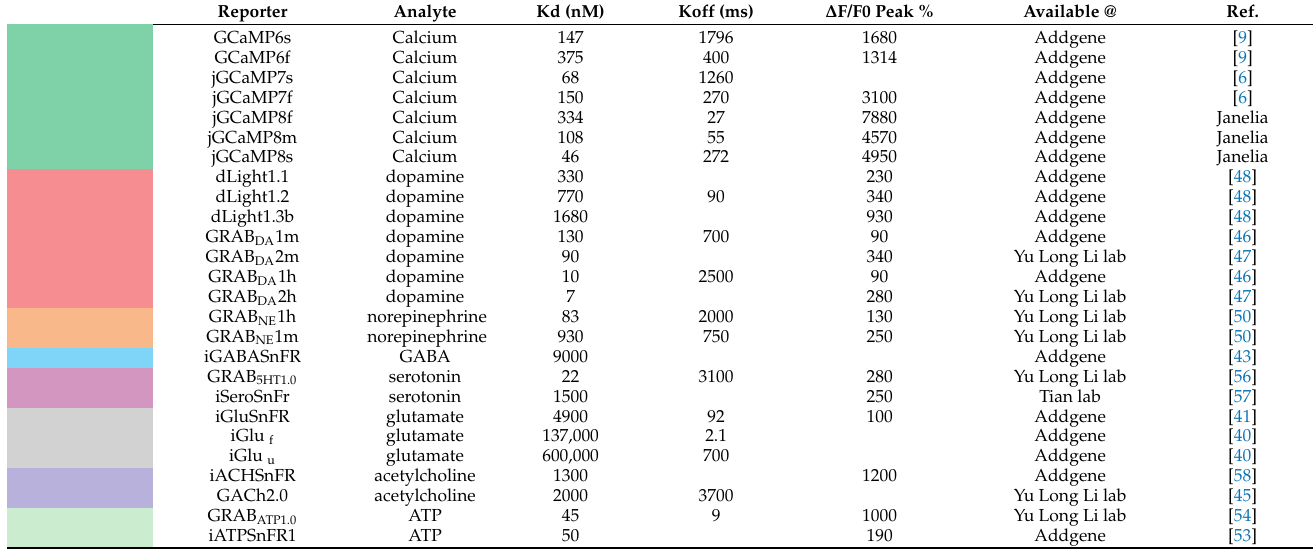
Table 1. Main properties of genetically encoded fluorescent reporters of endogenous biomolecules. Affinity (Kd), dissociation time constant (Koff), relative peak change in fluorescence over baseline signal ( ∆ F/F peak %), construct availability and relative reference (ref.) are reported for Calcium (green), Dopamine (red), Norepinephrine (orange), GABA (cyan), Serotonin (yellow), Glutamate (grey), Acetylcholine (purple), ATP (pink) and Adenosine (violet). Reporter Analyte